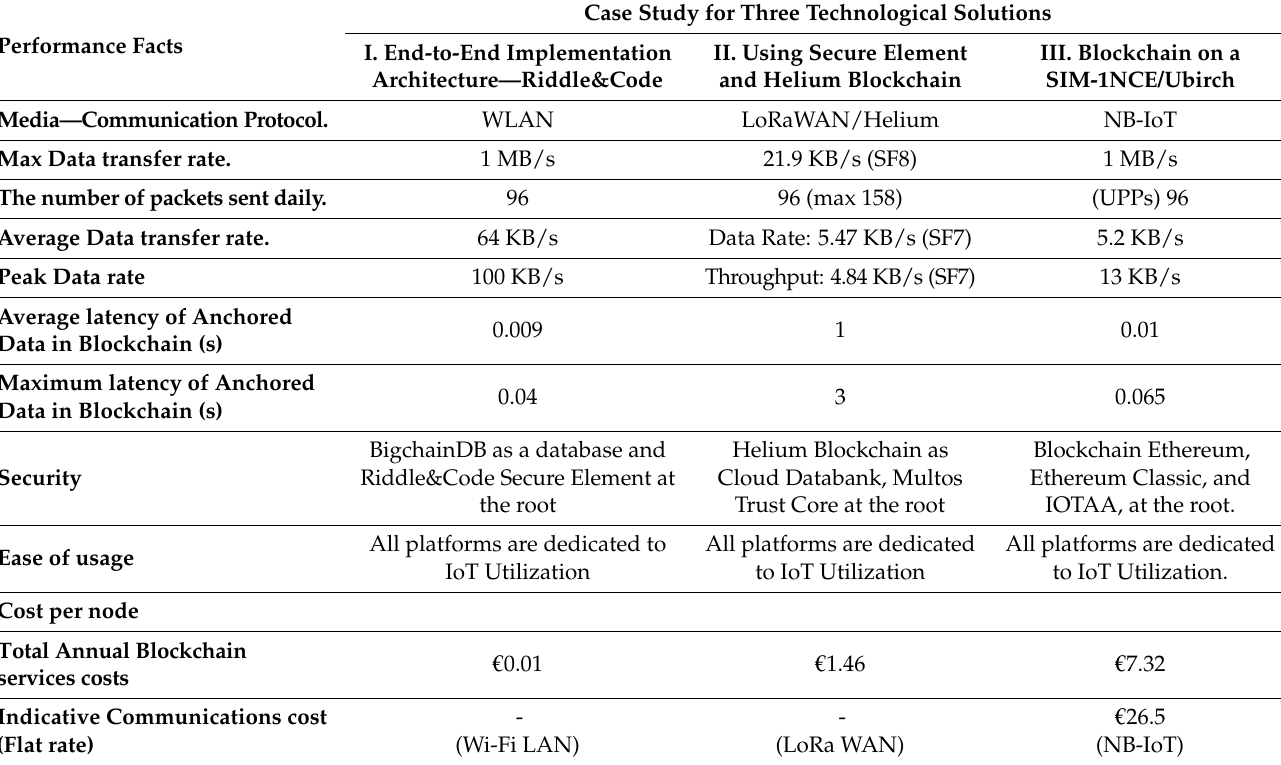
Table 7. Performance comparison table of all three